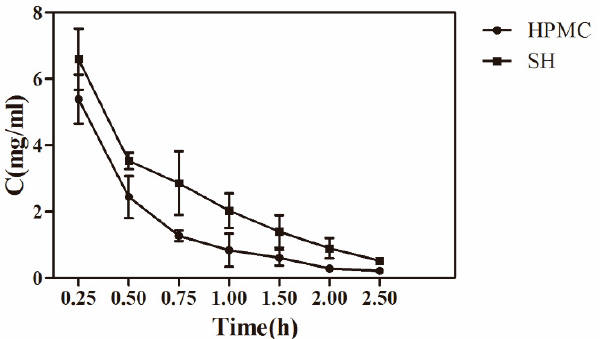
Figure 4. Concentration-time profiles of AZI in tear fluid after instillation of HPMC preparation and SH preparation in conscious rabbits ( n = 5). Table 2. Pharmacokinetics parameters of AZI in tear fluid after topical administration in the conscious rabbits ( n = 5).